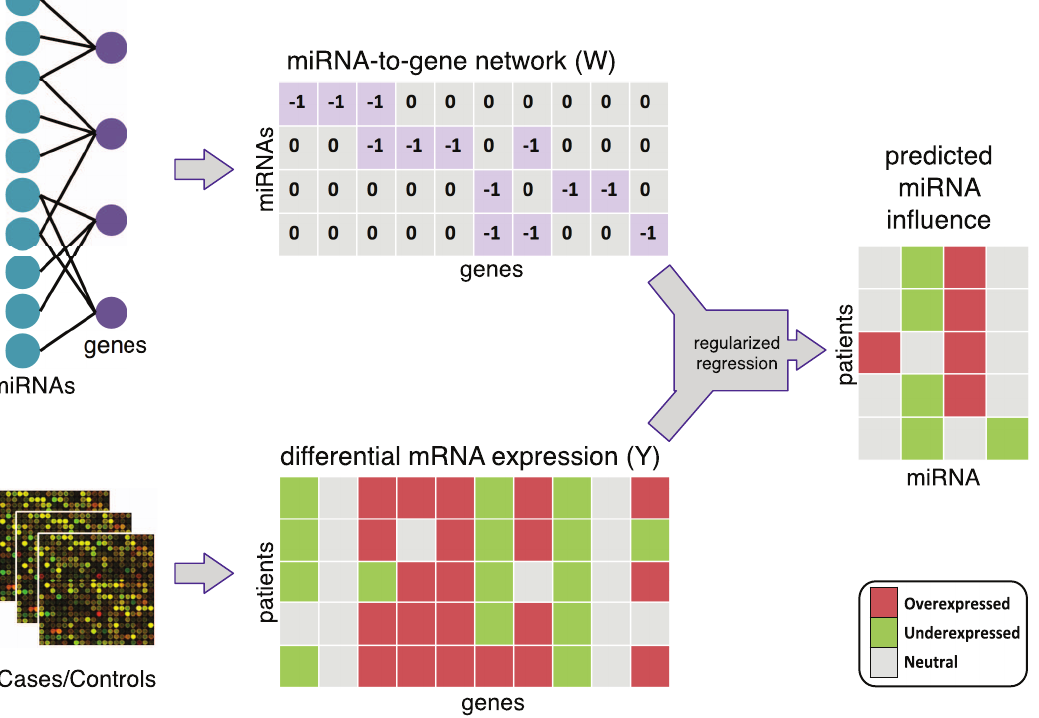
Figure 1. Flow chart of the active miRNAs prediction approach. We can predict the active miRNAs for each individual patient, then we investigate the coherence of the active miRNAs across patients.